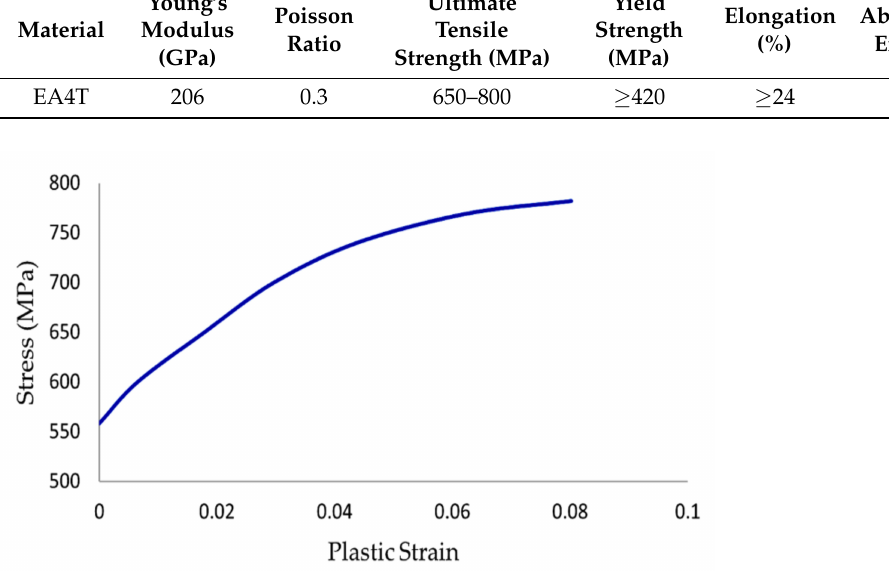
Figure 4. Stress–plastic strain curve for EA4T